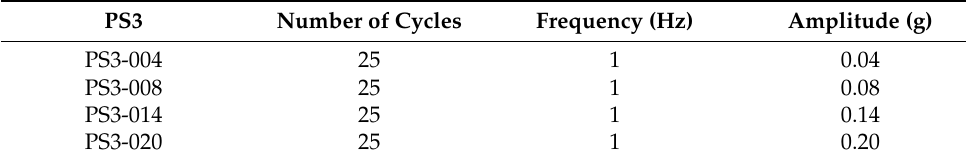
Table 6. Details of parametric study